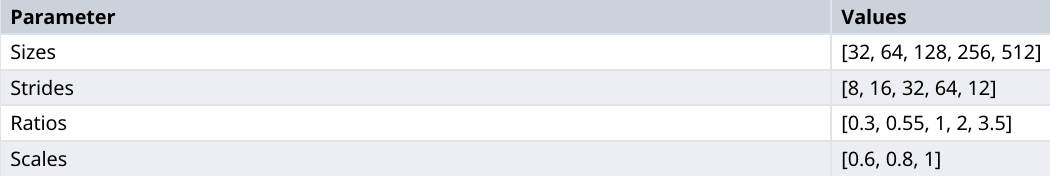
Table 3. A detailed specification of the modified neural network